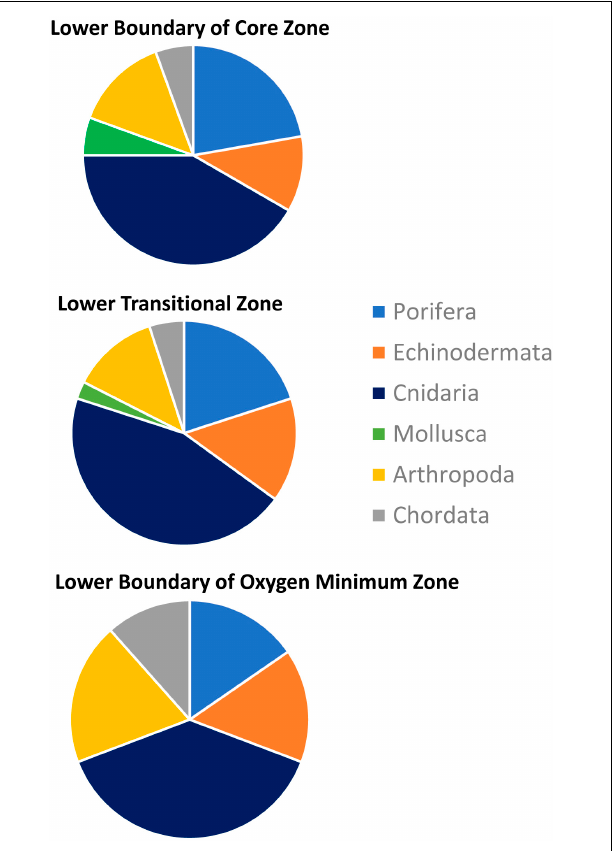
FIGURE 7 | Composition and proportional taxonomic richness by phylum through the oxygen minimum zones during dive D347 in the NW limit of Guaymas Basin and Sonoran